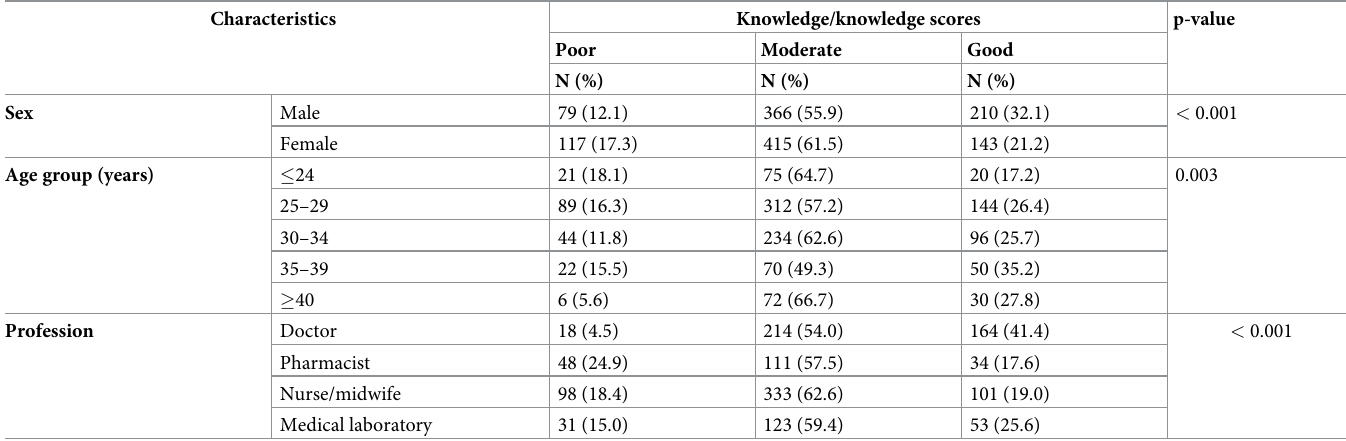
Table 3. Association of knowledge with demographic characteristics.